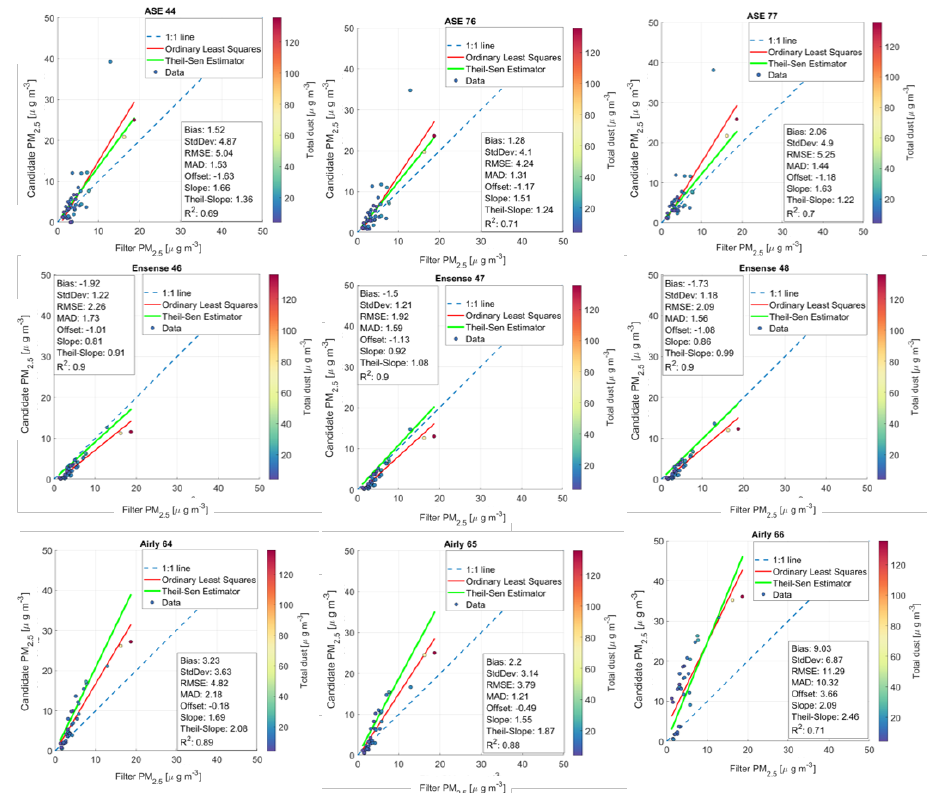
Figure 8. Sensor-to-KFG intercomparison of the factory-calibrated PM 2.5 signal of the 9 sensors systems against the KFG during the co-location period. Axes labels are shown here in units of µg m − 3 . The dashed blue line represents the 1:1 reference line. The red line shows a linear regression fit to the data (with the corresponding regression statistics and R 2 value provided in the top left corner), whereas the green line indicates Theil–Sen